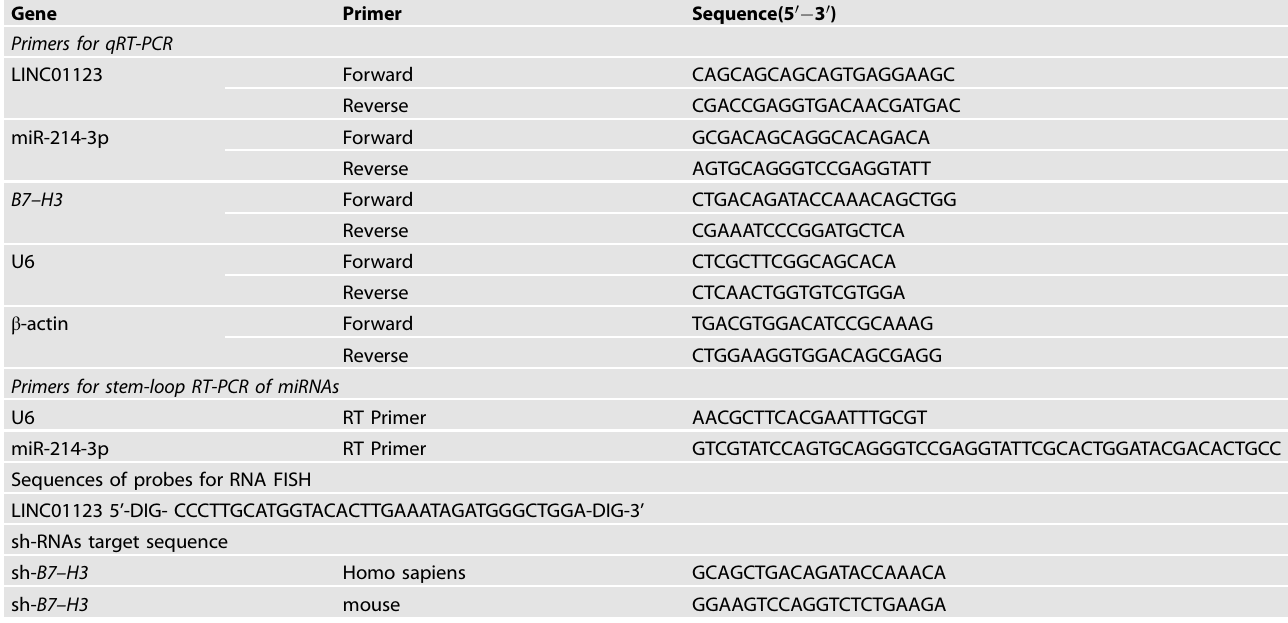
Table 1. The list of primers and